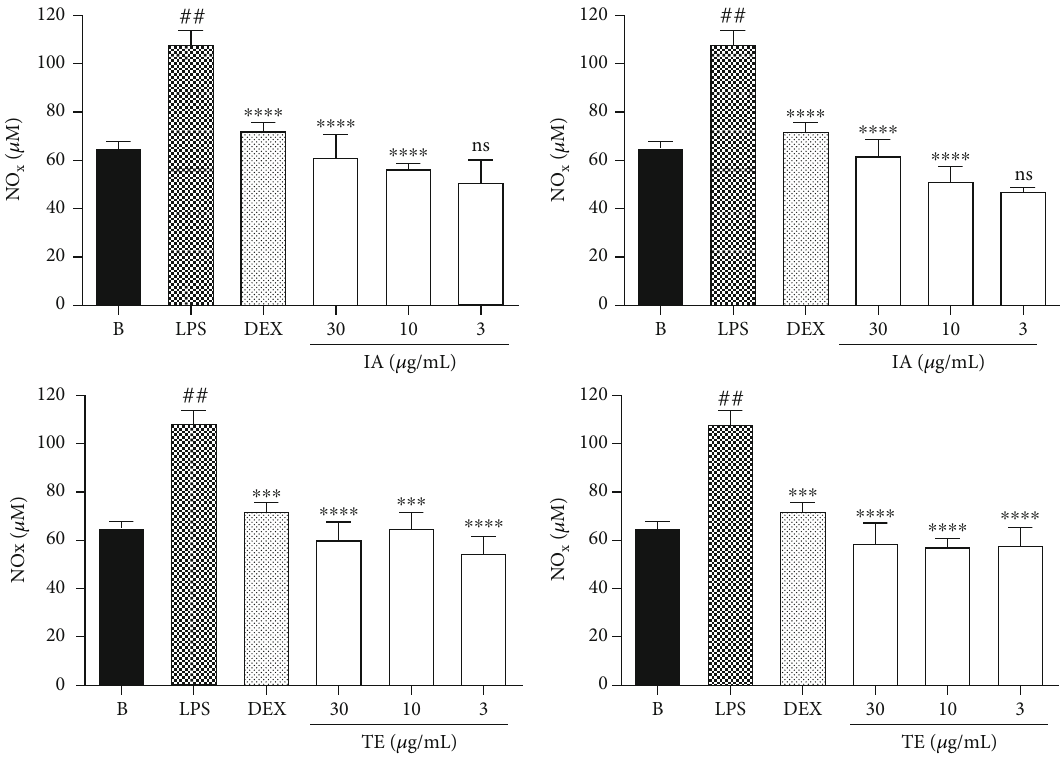
Figure 6: E ff ects of Ilex paraguariensis extracts on NOx level in LPS-treated RAW 264.7 macrophages. B: untreated cells; LPS: cells treated with only lipopolysaccharide (1 μ g/mL); DEX: cells pretreated with dexamethasone (7 μ M) before LPS administration. Results were expressed as mean ± SEM ; n = 3 ; ∗∗∗ p < 0 : 001 and ∗∗∗∗ p < 0 : 0001 vs. group LPS; ## p < 0 : 01 vs. group B. IA: aqueous infusion; IE: ethanolic infusion; TA: aqueous turboextraction; TE: ethanolic turboextraction.